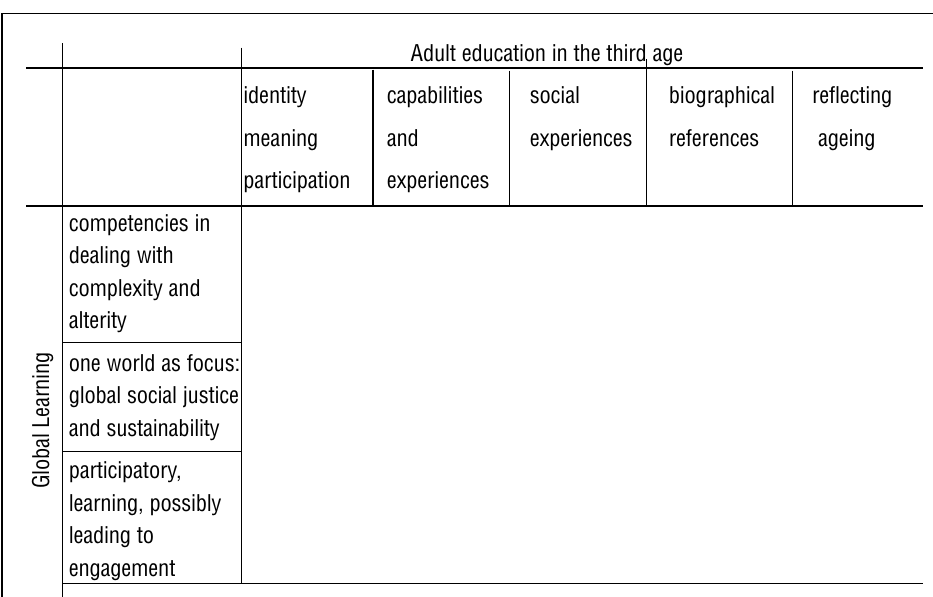
Table 1: Global Learning in the Third